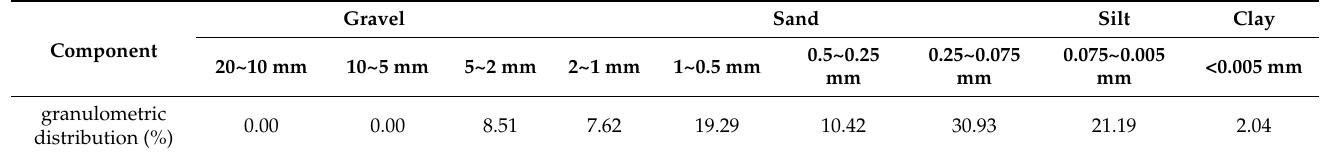
Table 1. Sediment particle test report.